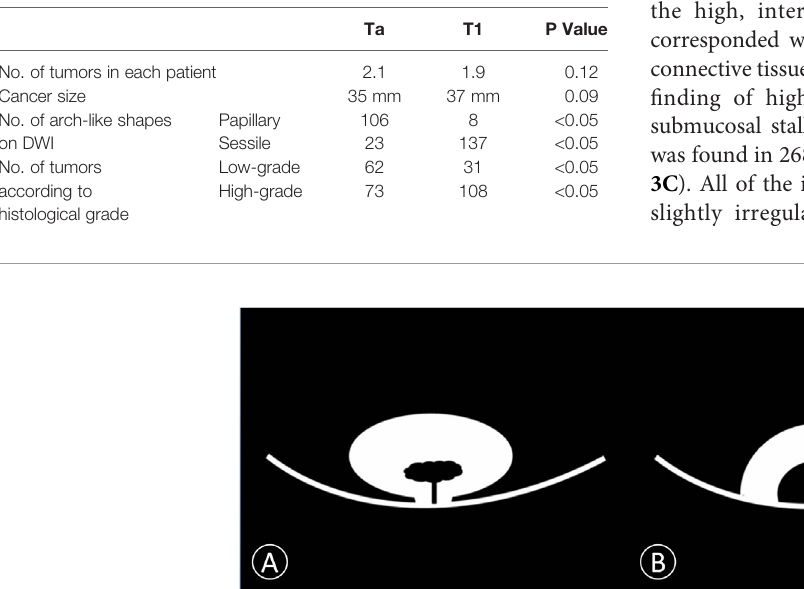
TABLE 4 | Related Indicators in Non-invasive Bladder Cancer (Ta and T1).